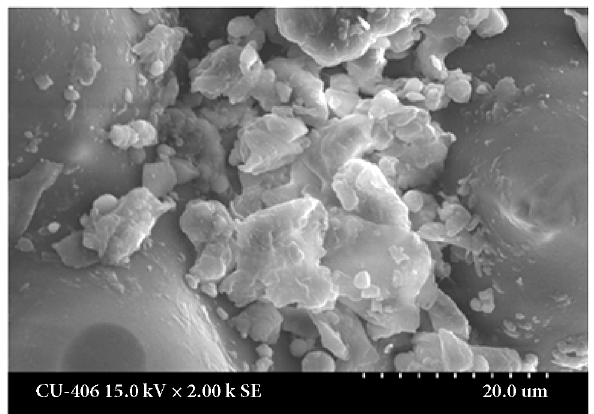
Figure 1. SEM image of the rice husk